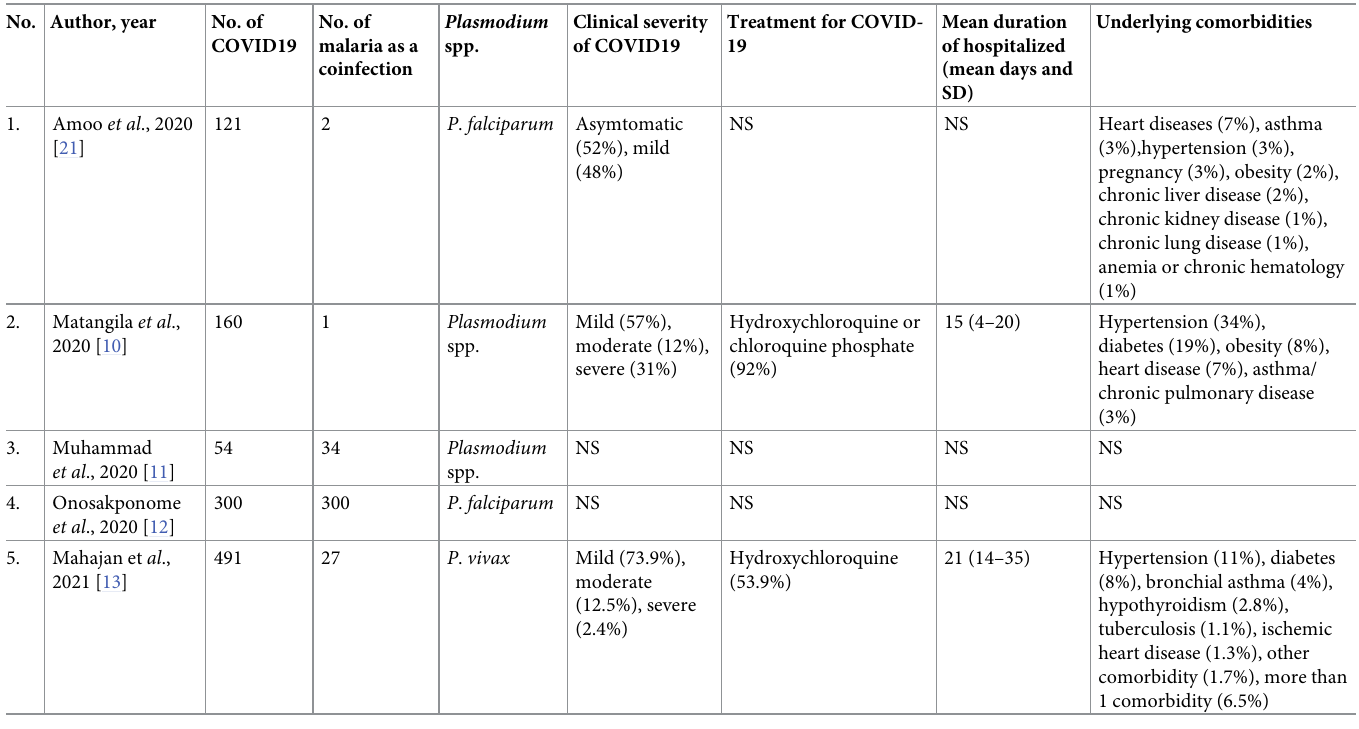
Table 2. Clinical characteristics of